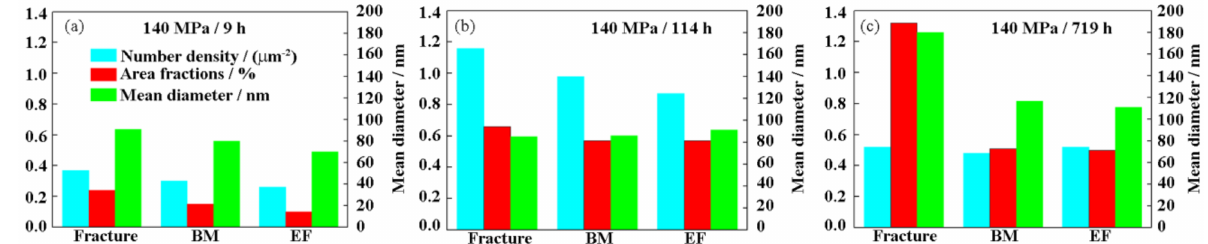
Figure 10. The size of Laves phase under different applied stresses: ( a ) 140 MPa; ( b ) 120 MPa; ( c ) 100 MPa.